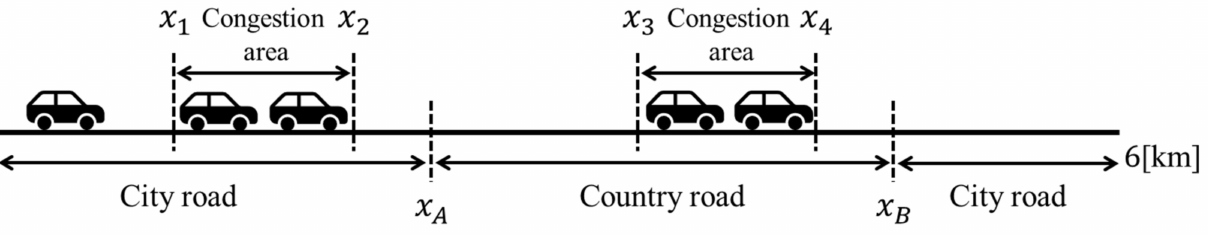
Figure 5. The figure of Road A.